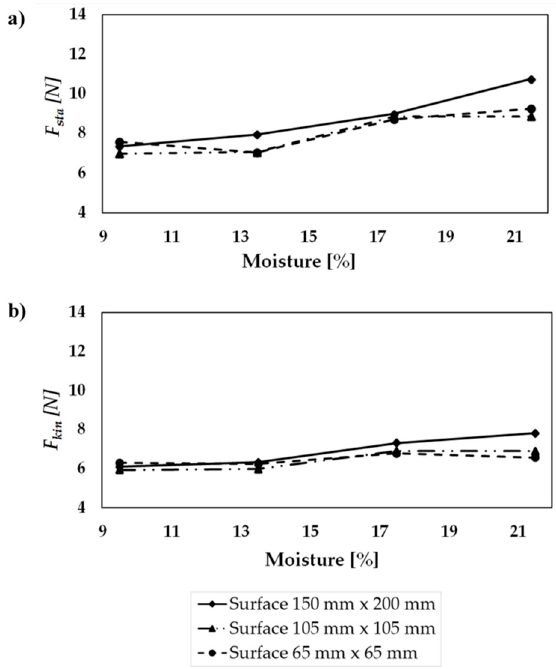
Figure 7. A chart showing the relationship of force of friction to the moisture level of buckwheat: ( a ) static friction, ( b ) kinetic friction.